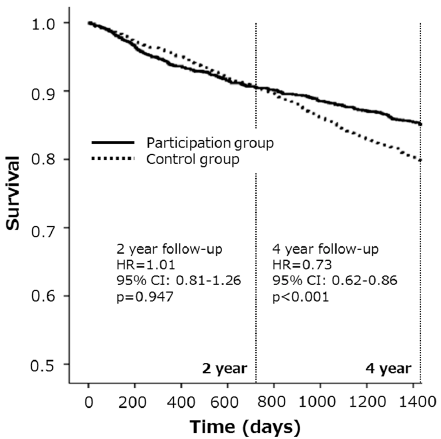
Figure 1. Kaplan-Meier survival curves for new LTCI service requirements are presented to compare the disability incidence in the total cohort. During the two-year follow-up period, 9.6% of participants in the participation group and 9.6% of the participants in the control group were newly certified for LTCI service requirements. Similarly, during the four-year follow-up period, 15.2% in the participation group and 20.6% in the control group were newly certified for long-term care insurance (LTCI) service requirements. During the four-year follow-up period but not the two-year follow-up period, the participation group, compared with the control group, had a significantly reduced risk for LTCI service needs (hazard ratios (HR) = 0.73, 95% CI = 0.62–0.86).